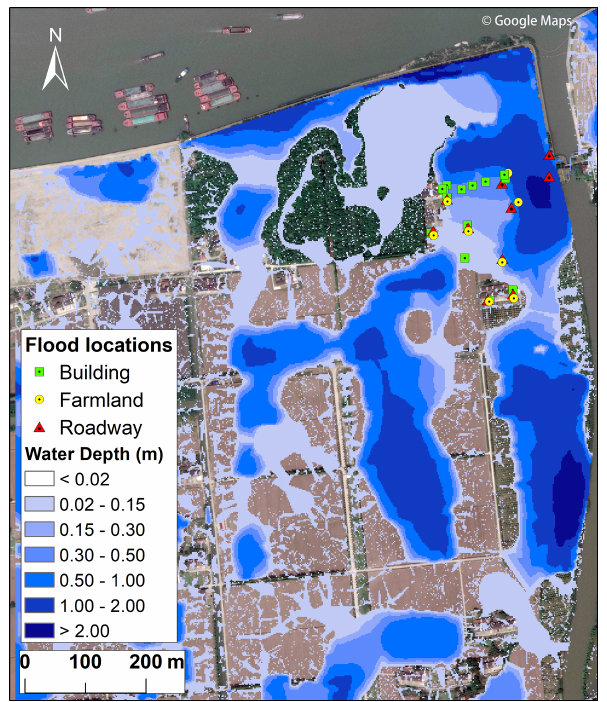
Figure 5. Maximum flood extent and depth predicted by the model.